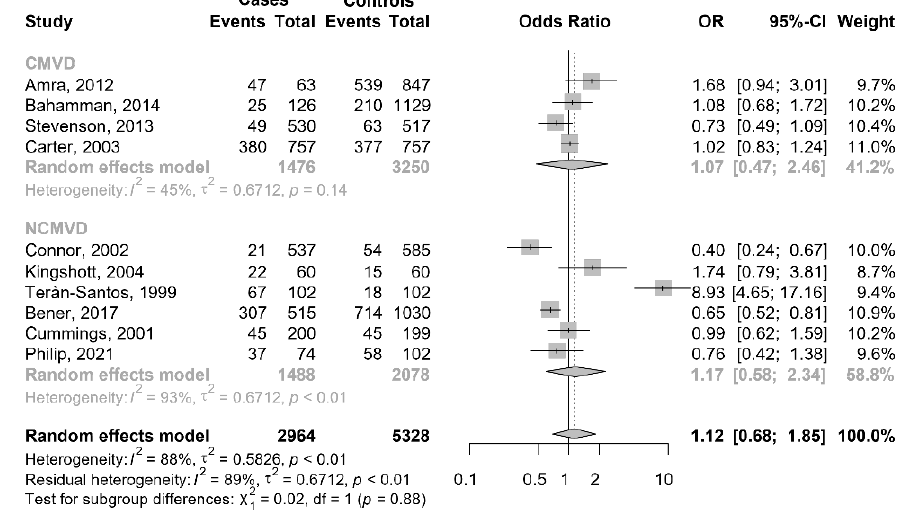
Figure 7. The forest plot of the meta-analysis of ESS ≥ 10 and car crashes [27,31,37,58]. Events Cases are defined as car crashes with ESS ≥ 10 (total of 1062) and Total Cases as subjects with ESS ≥ 10 (2678); Events Controls are defined as car crashes without ESS ≥ 10 (total 2405) and Total Controls as subjects without ESS ≥ 10 (7141). The wh iskers represent the 95% confidence interval (CI). The